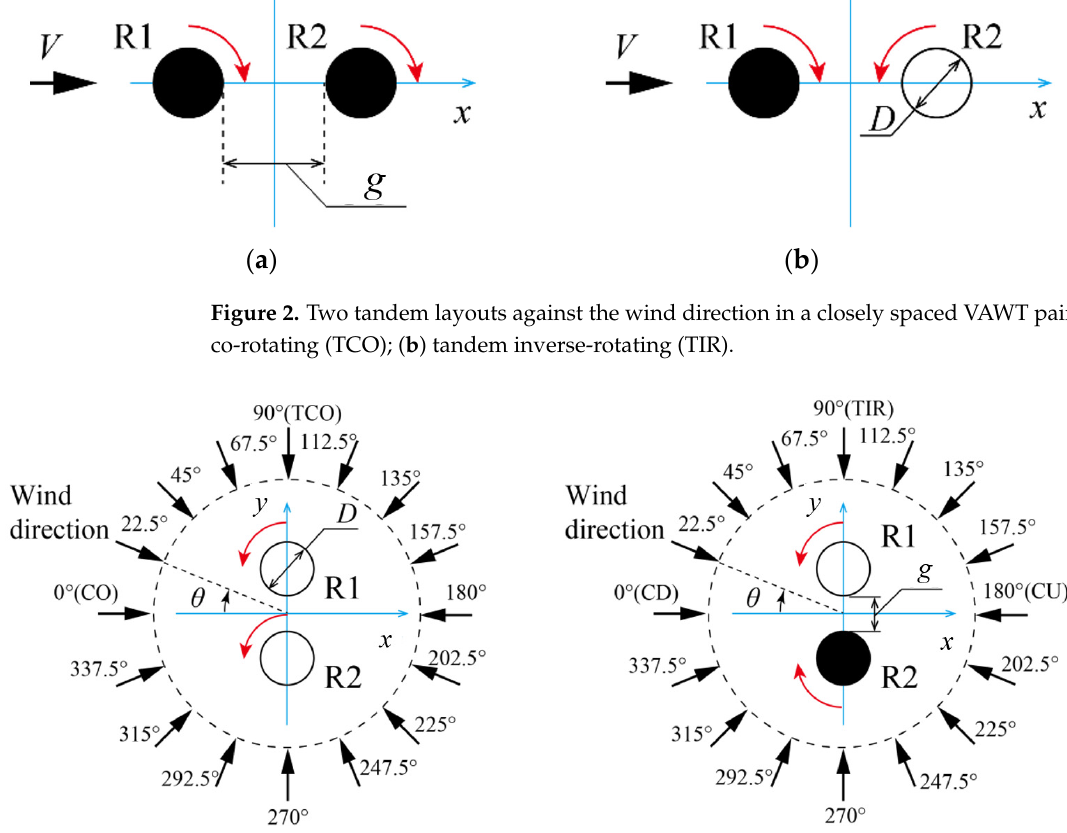
Figure 2. Two tandem layouts against the wind direction in a closely spaced VAWT pair: ( a ) tandem co ‐ rotating (TCO); ( b ) tandem inverse ‐ rotating (TIR).